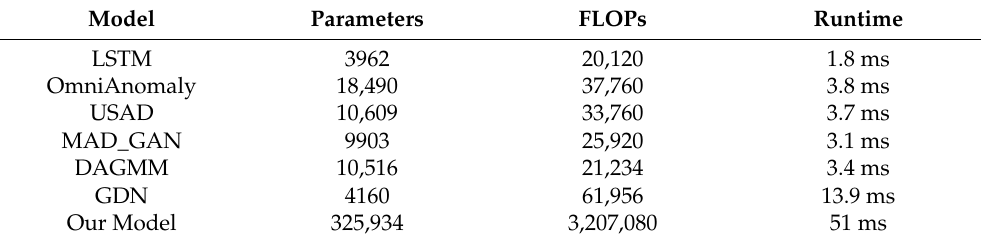
Table 3. Model complexity.